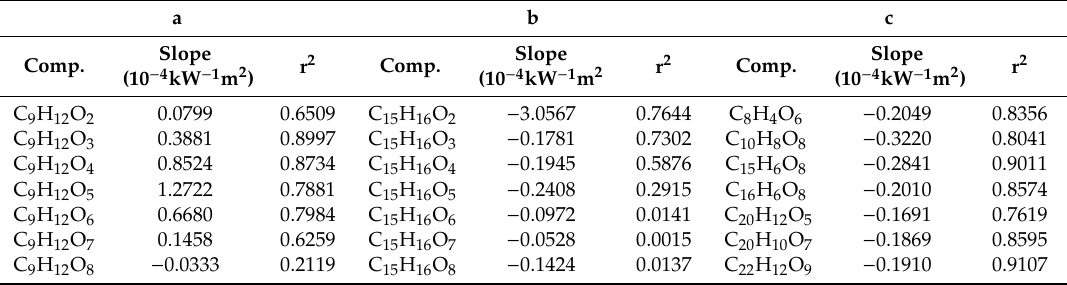
Table 2. Examples of the slope values and the coefficient of determinations of the molecular formulas of Figure 7. a b